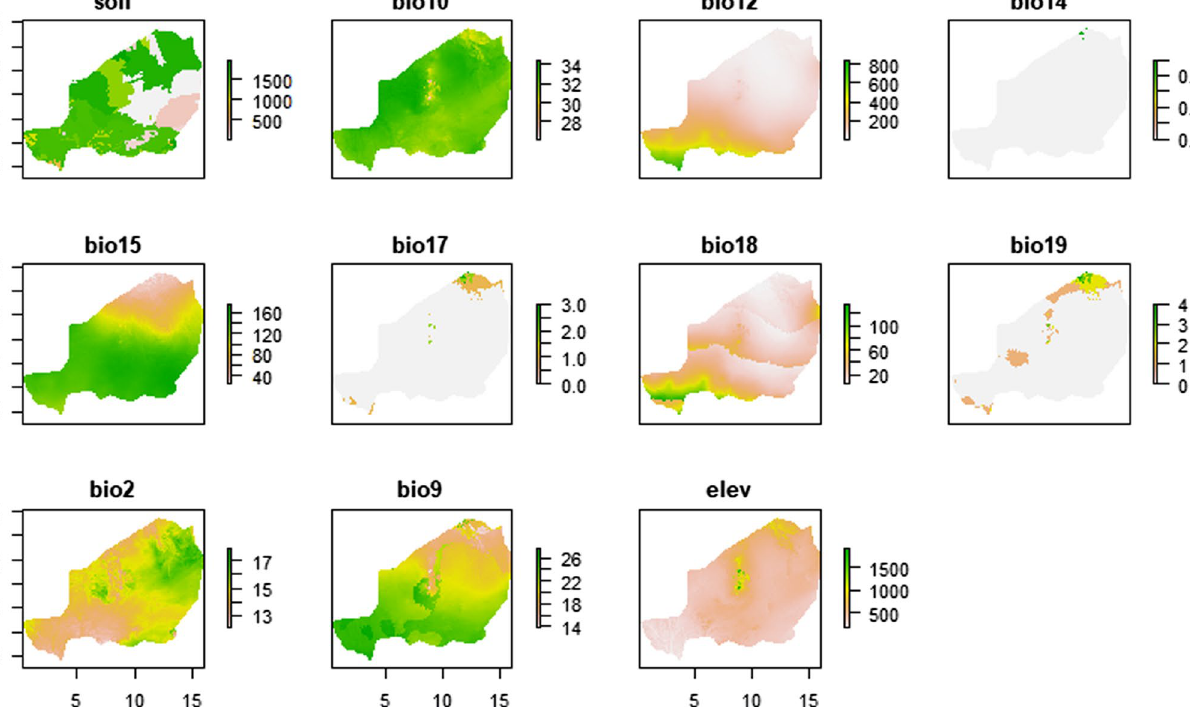
Fig. 1 Main environmental variables contributing to the